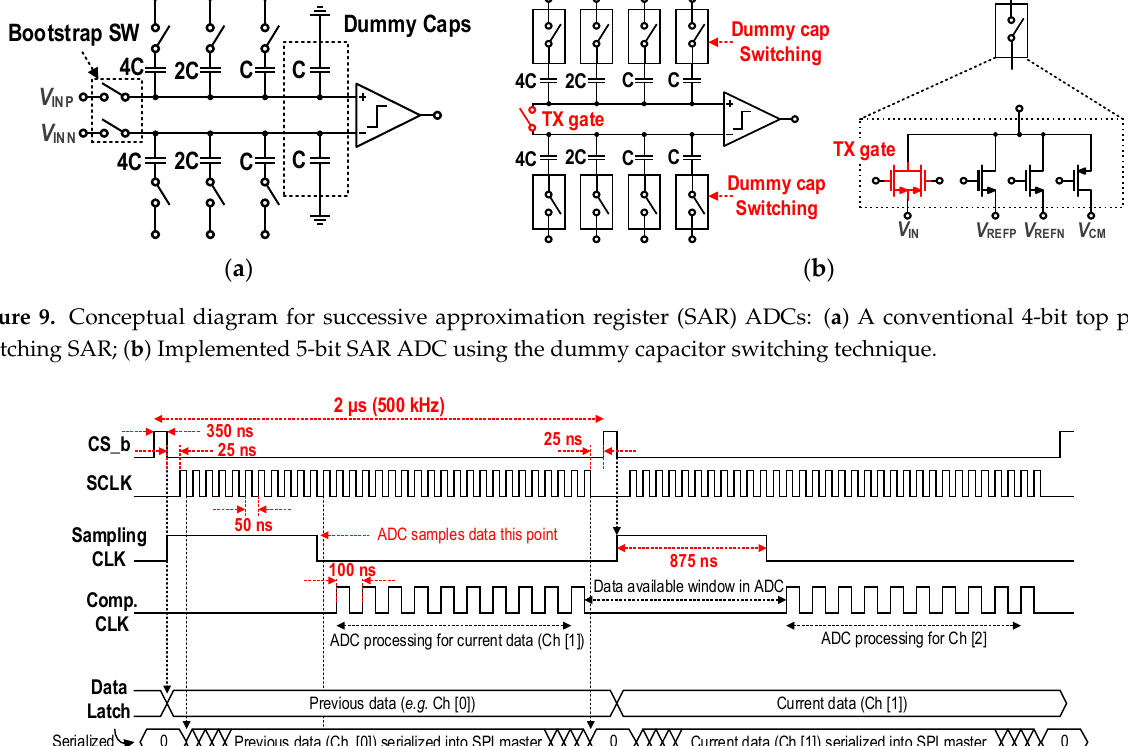
Figure 9. Conceptual diagram for successive approximation register (SAR) ADCs: ( a ) A conventional 4-bit top plate switching SAR; ( b ) Implemented 5-bit SAR ADC using the dummy capacitor switching technique.